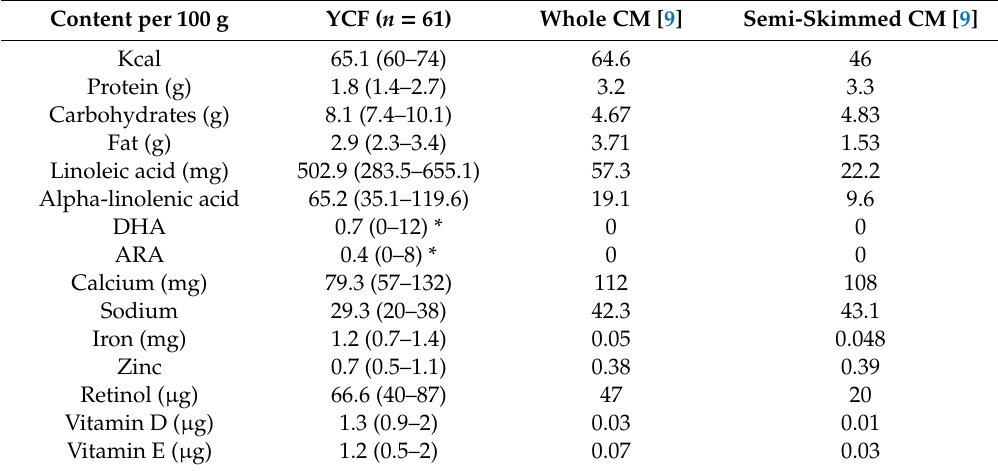
Table 1. Mean (range) composition of relevant nutrients from cow’s milk (CM) and YCF that were consumed during the